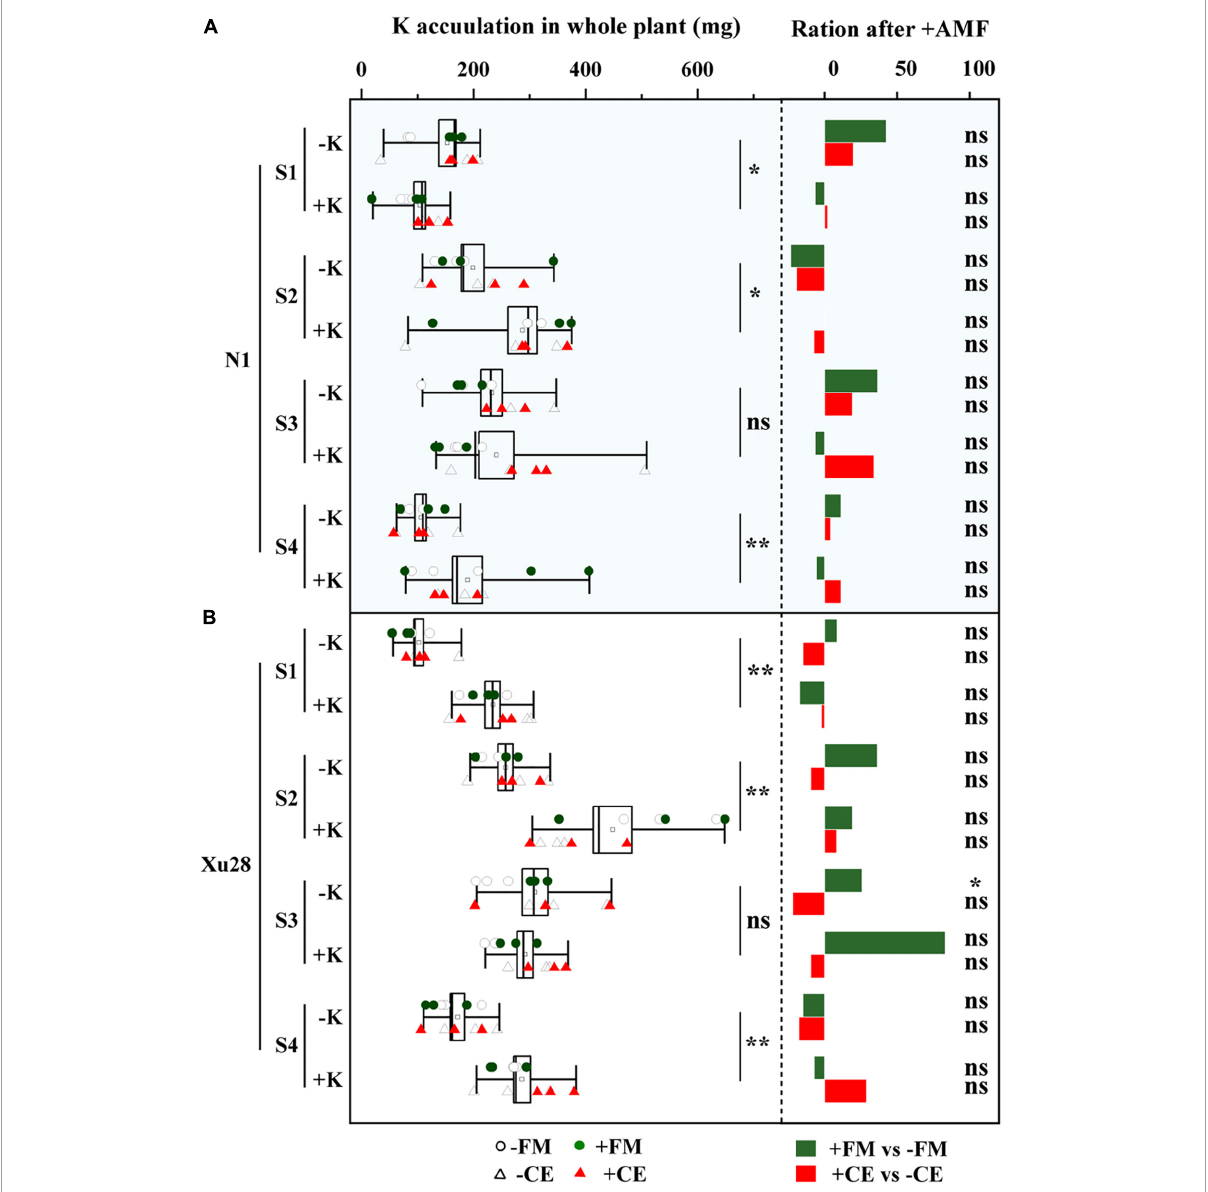
FIGURE7 The effects of potassium application and arbuscular mycorrhizal fungi inoculation on K concentration (A) and K accumulation (B) of sweet potato. For each growth stage, different lowercase letters indicate significant differences between different groups ( P < 0.05). For different groups, asterisks denote significant differences after arbuscular mycorrhizal fungi (AMF) inoculation ( t -test; * P < 0.05; ** P < 0.01), while “ns” indicates nonsignificant